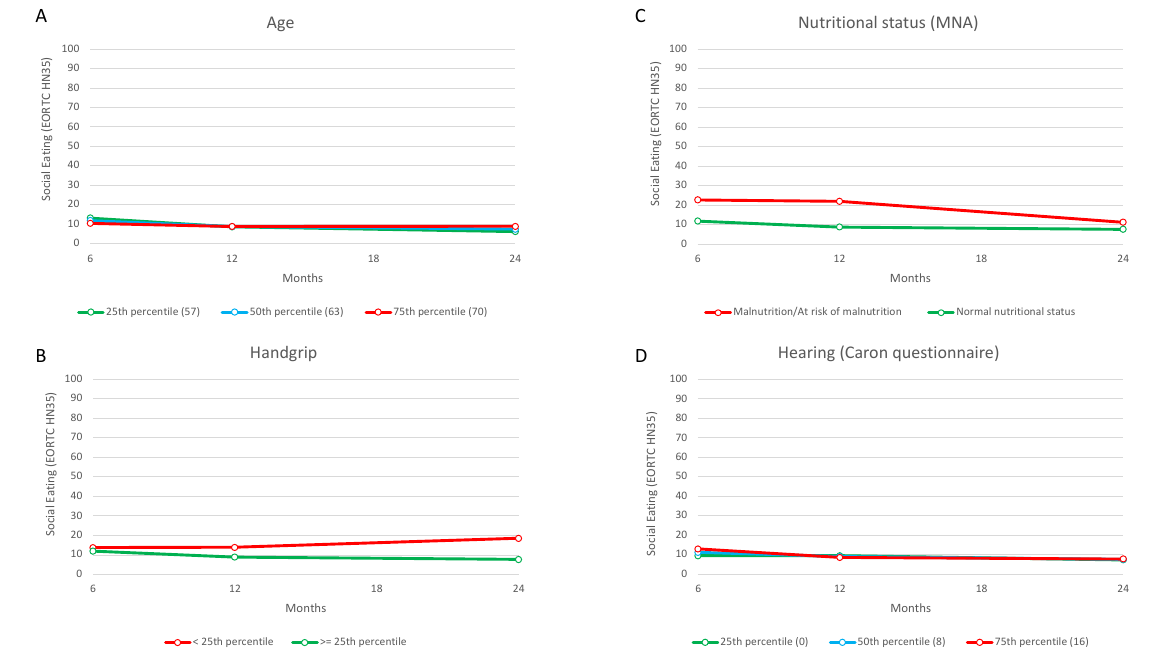
Figure 4. The change in social eating problems (EORTC QLQ HN35) from 6 to 24 months after treatment in relation to age ( A ), muscle strength ( B ), nutritional status ( C ), and hearing problems ( D ) at 6 months.